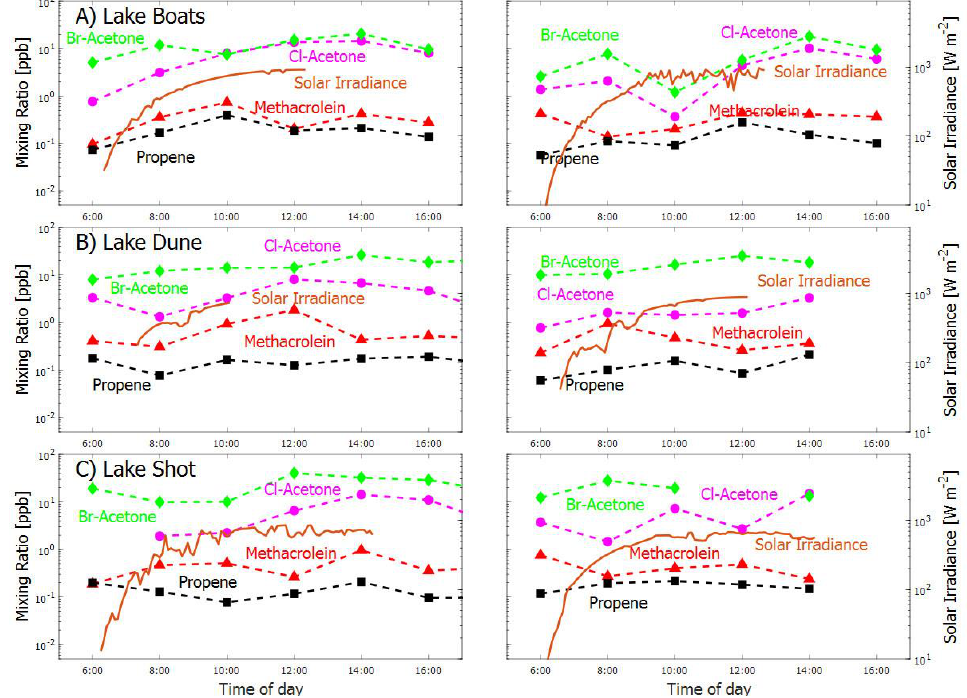
Figure 1. Measured propene, methacrolein, chloro- and bromoacetone mixing ratios. The